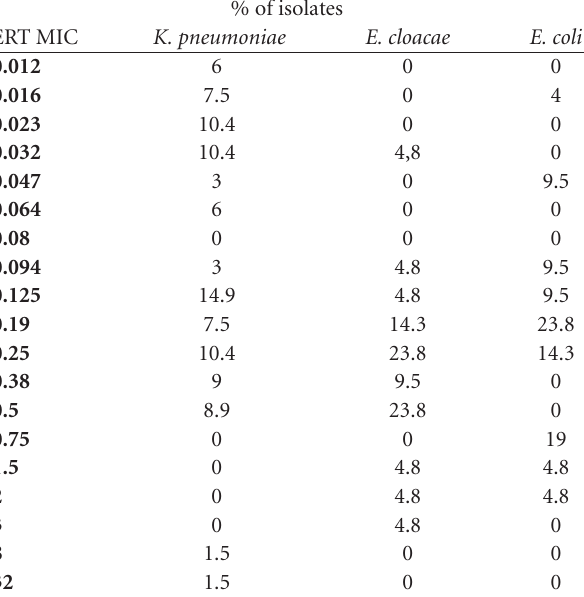
Table 2: Imipenem (IMP) and Ertapenem (ERT) MIC distribution of extended spectrum beta-lactamase-producing Enterobacteri- aceae.